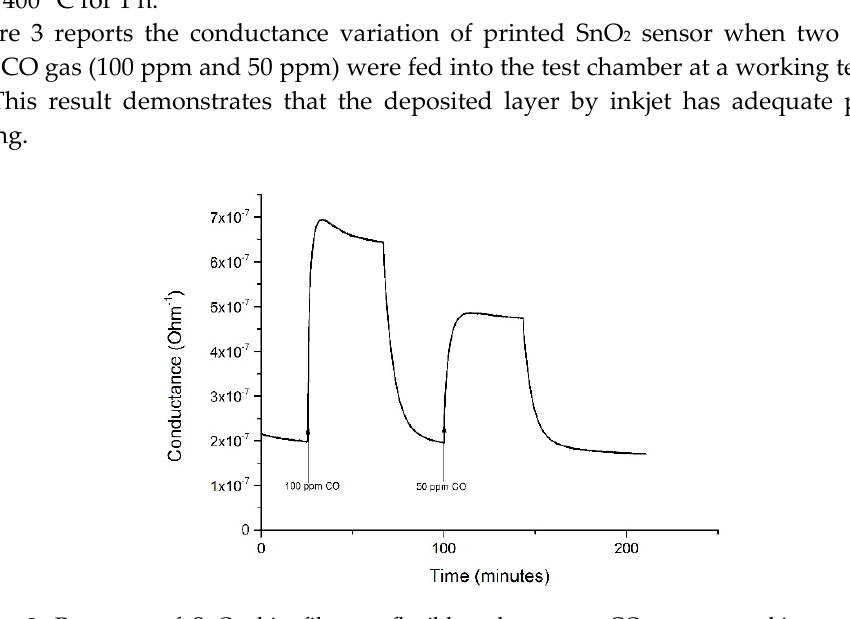
Figure 3. Response of SnO 2 thin film on flexible substrate to CO gas at working temperature of 300